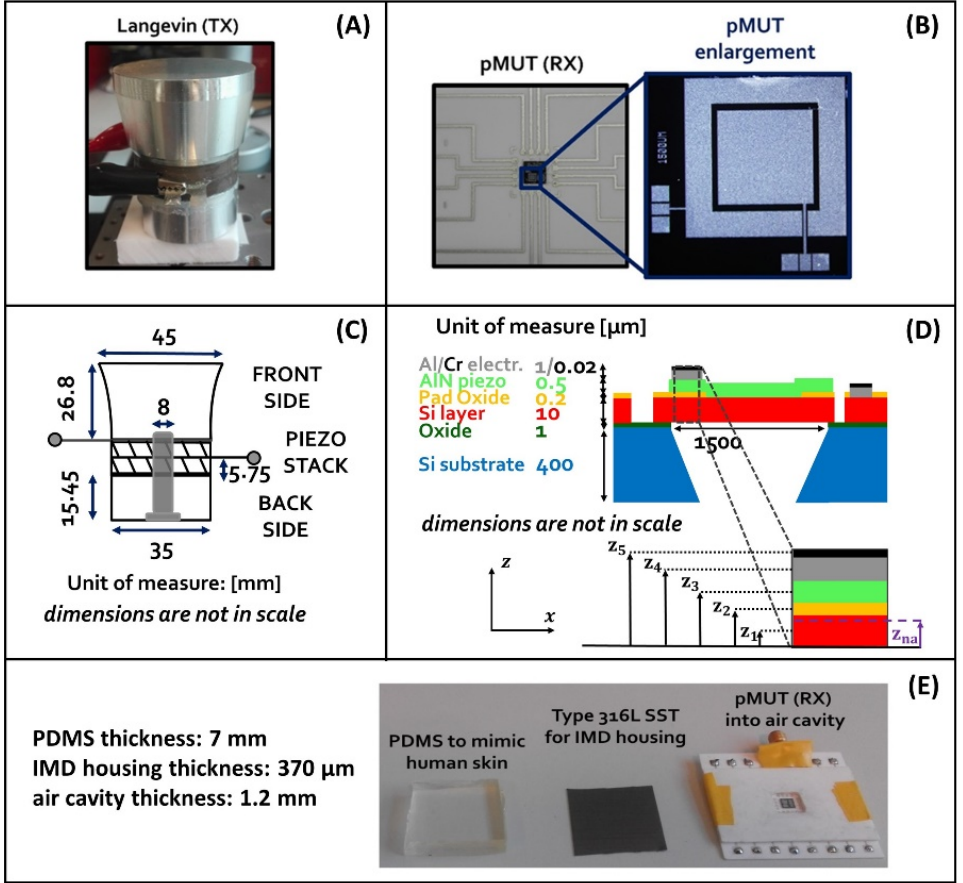
Figure 2. Elements constituting the UPD system. Langevin transducer ( A ); square pMUT ( B ); Langevin transducer geometrical dimensions ( C ); square pMUT structure ( D ); medium lay- ers and air cavity structure for the pMUT placement ( E ).